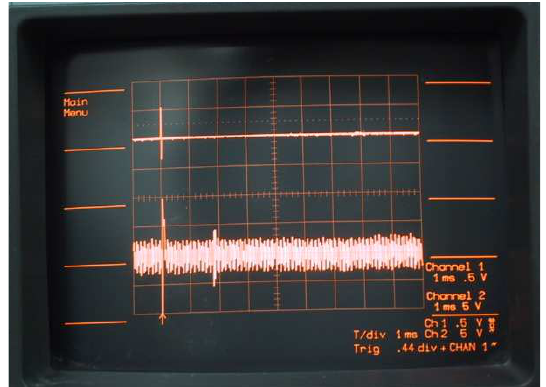
Fig. 3. Initial current pattern generated by the 2.85-MHz Hertzian antenna, seen in Fig. 1, as measured through a 10:1 voltage attenu- ator with the 0.05 V/A monitor, seen in Fig. 2. Each major vertical division corresponds to 400 A. Each major horizontal division is 0.2 µ s.